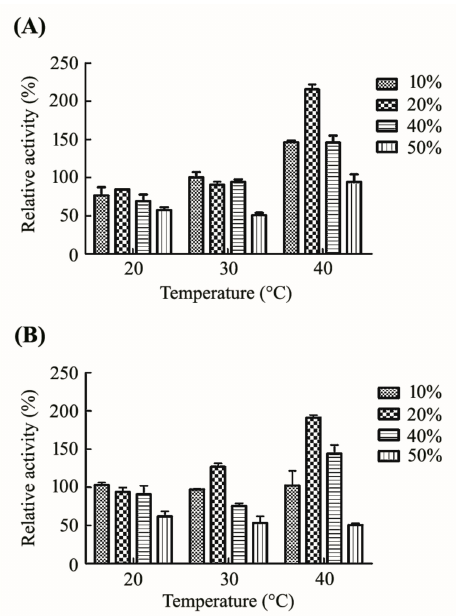
Figure 5. The e ff ect of glycerol on the thermo-stability (20, 30, 40 ◦ C) of CsnB. ( A ) Residual activity after pretreatment for 30 min. ( B ) Residual activity after pretreatment for 60 min. The activities of CsnB without glycerol at the same temperature were defined as the control at 100%.